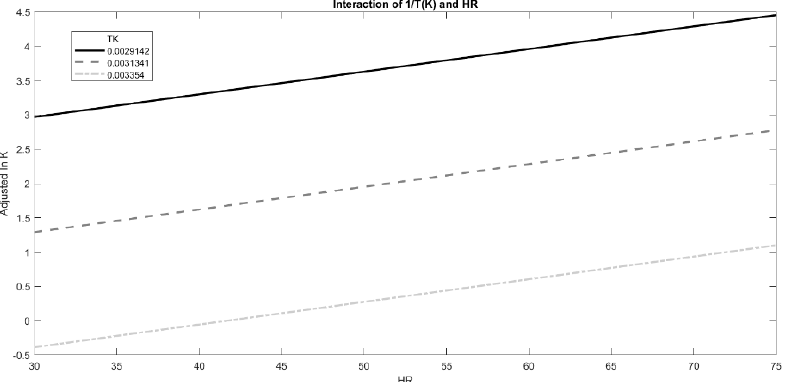
Figure 8. Interaction plot of the effect exerted by growing RH % on lnK at fixed T values (1/T (K)), represented by the different lines.